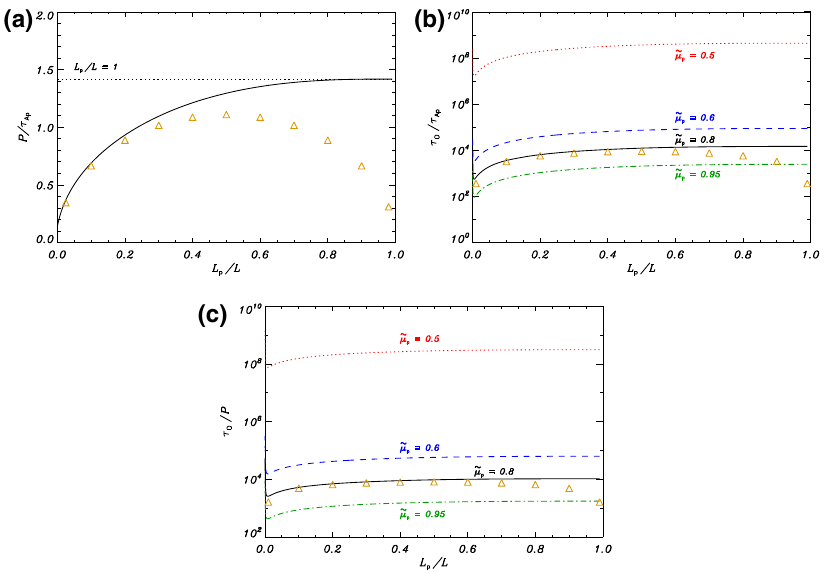
Fig. 80 Results for the thread model in Fig. 79 without transverse transitional layer and for the prominence thread located at the central part of the magnetic tube. a Period, P , of the fundamental kink mode in units of the internal Alfvén travel time, τ Ap , as a function of L p / L . The horizontal dotted line corresponds to the period of the kink mode in a homogeneous prominence cylinder. The symbols are the analytic solution (Eq. 24 in Soler et al. 2010a). b Damping time, τ d , in units of the internal Alfvén travel time, τ Ap , as a function of L p / L . The different lines denote ˜ μ p = 0.5 (dotted), 0.6 (dashed), 0.8 (solid) and 0.95 (dash- dotted). The symbols are the analytic approximation for ˜ μ p = 0 . 8 (Eq. 27 in Soler et al. 2010a). c τ d / P versus L p / L . The line styles have the same meaning as in ( b ) and the symbols are the approximation given by Eq. (41). Image reproduced with permission from Soler et al. (2010a), copyright by